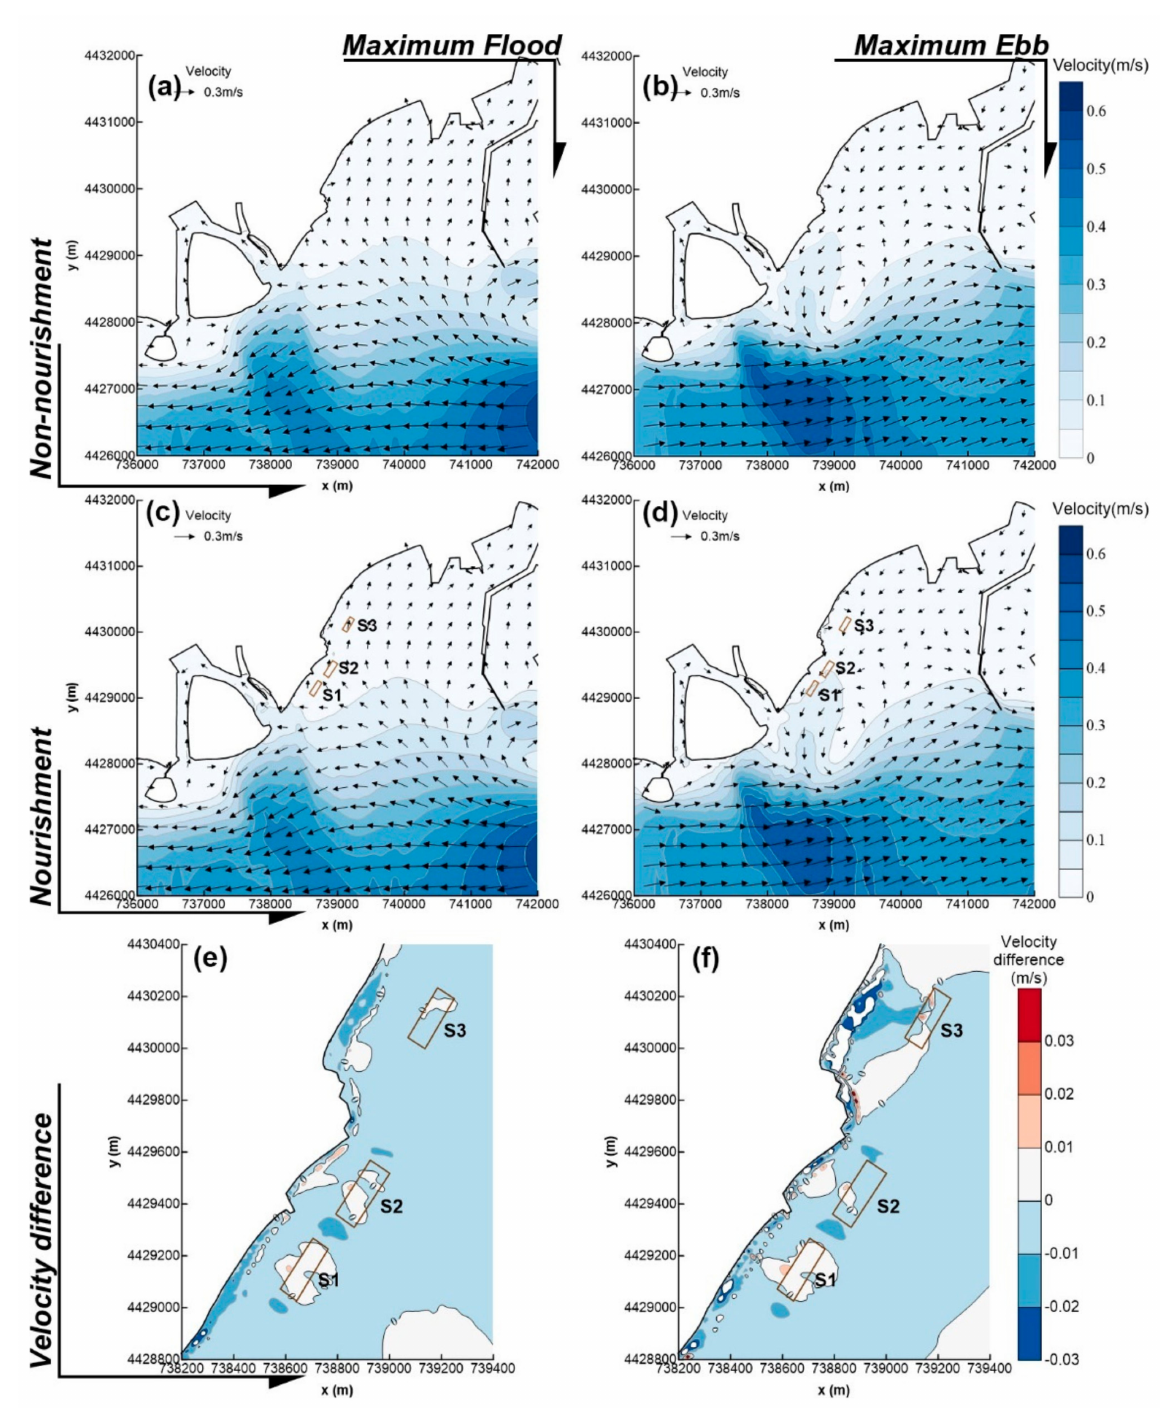
Figure 8. Current fields in scenarios ( a , b ) without and ( c , d ) with beach nourishment, and ( e , f ) the velocity difference under coupled tide and waves at the maximum flood and ebb in the spring tide circle on 12 October